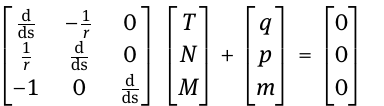
in the positive direction of the Y* axis (where Y*Z* is a sys- tem of right-handed axes travelling along the axis of the beam), the tangential displacement w is positive if it is in the positive direction of the curvilinear coordinate s , and finally the variation of the angle φ is positive if it is coun- terclockwise (Fig.